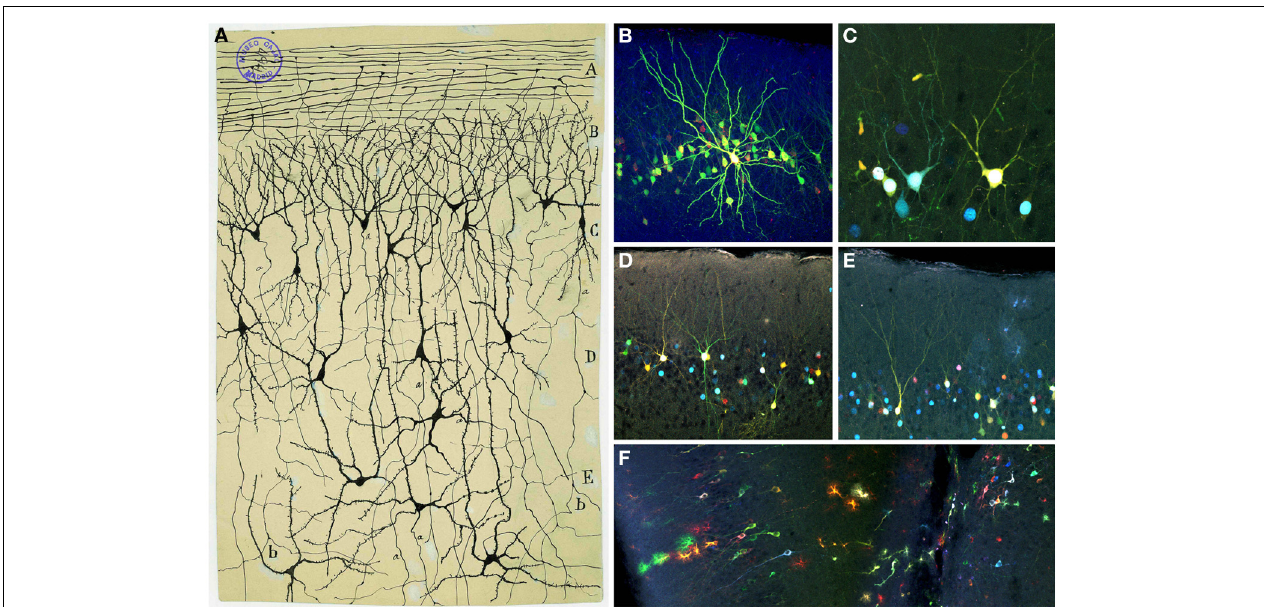
FIGURE 11 | Olfactory cortex. (A) Original Cajal drawing showing the olfactory cortex layers (Ramón y Cajal, 1901). O lfactory fibers layer (A) ; plexiform layer (B) ; layer of polymorphic superficial cells (C) ; layer of the pyramids (D); deep polymorphous cells (D) . (b) Bifurcation of axons. Cajal Legacy (Instituto Cajal, CSIC, Madrid, Spain). (B–F) Different cell morphologies in the adult mouse olfactory cortex labeled after E12